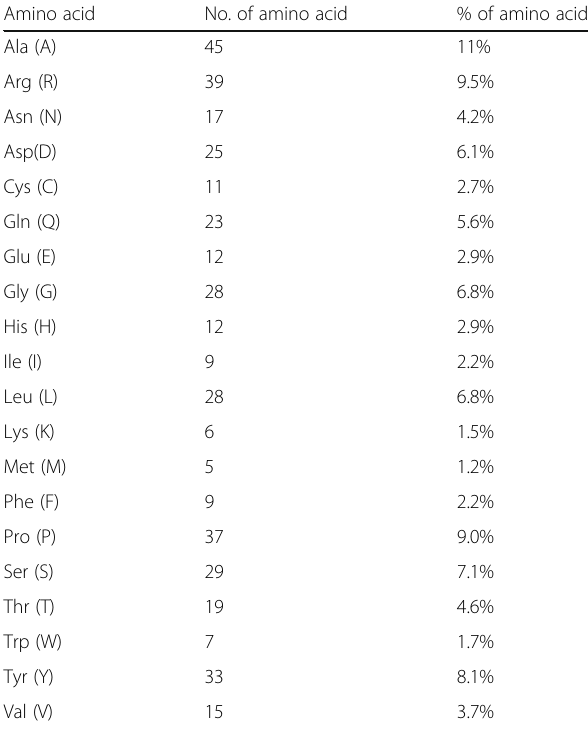
Table 1 Amino acid composition of lysyl oxidase protein Amino acid